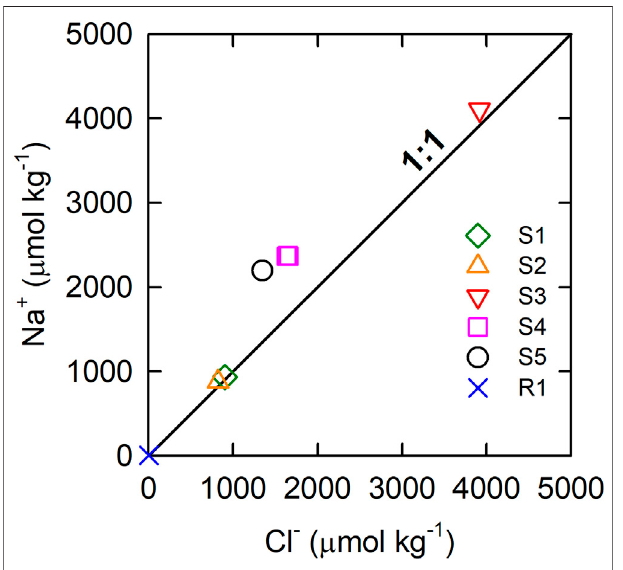
FIGURE 3 | Na − vs. Cl − of the rainwater and spring waters on Liuqiu Island. Table 1 shows the information in detail. The solid line shows the 1:1 ratio.